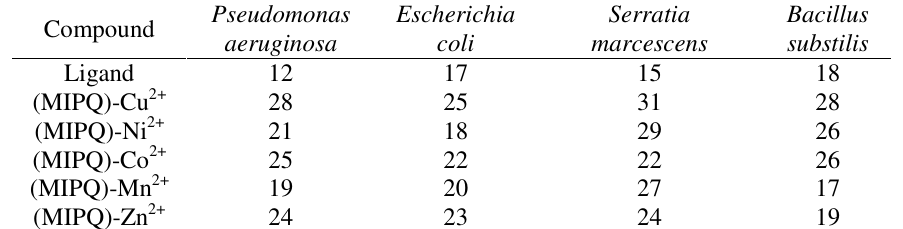
Table 3. Antimicrobial activity of MIPQ lidand and its heterochelates Pseudomonas Compound